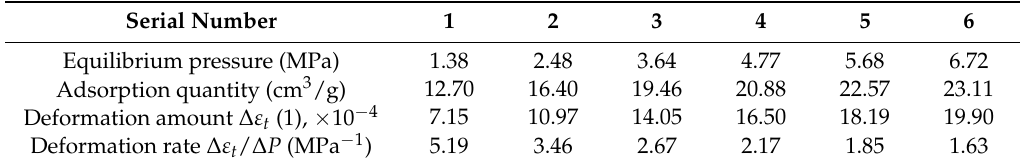
Table 2. The coal matrix deformation amount and deformation rate at the methane adsorption stage.